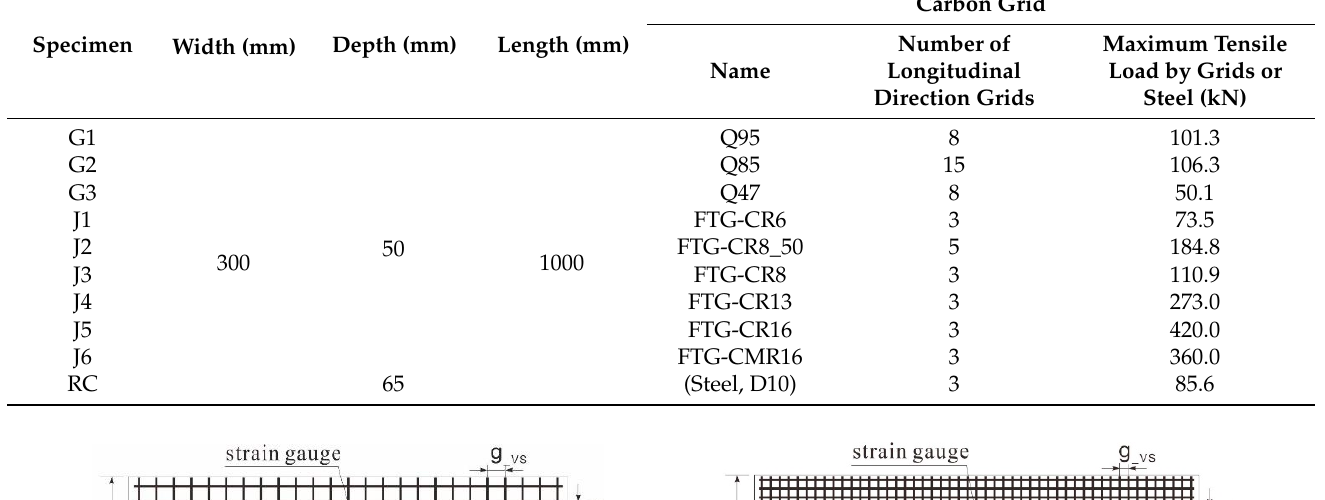
Table 1. Specifications of the one-way slab specimens.